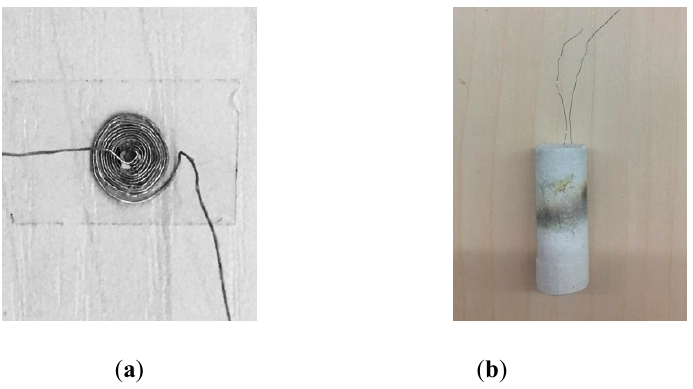
Figure 4. ( a ) Sensor coil before encapsulation; ( b ) sensor after encapsulation.